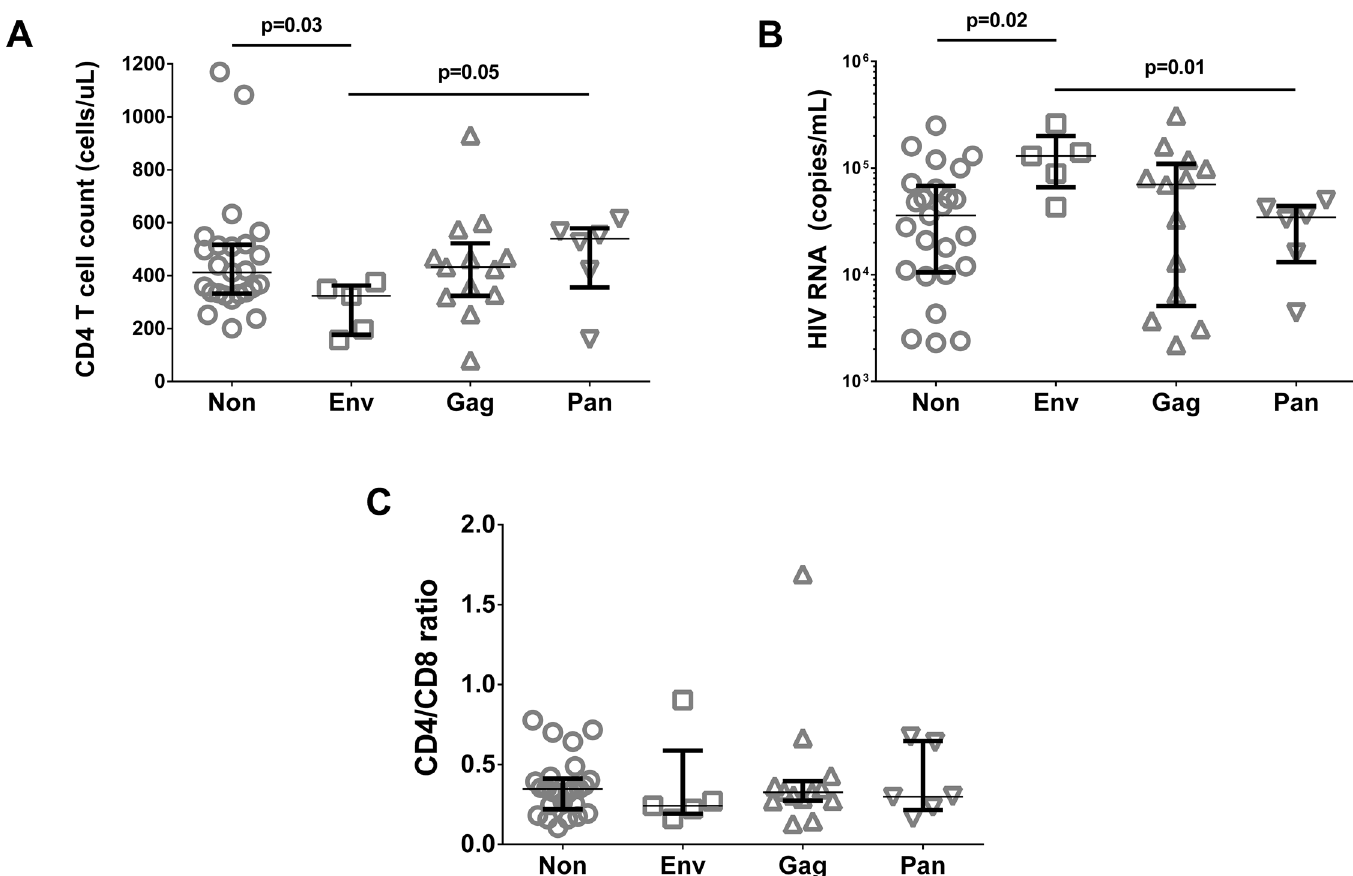
Fig 4. Lower CD4 counts and higher HIV viral loads in Env-regulators. (A) CD4 count, (B) Plasma HIV RNA and (C) CD4/CD8 ratio by regulator subgroup in the expanded cohort (n = 49). Median and upper/lower quartiles indicated. P-values derived from unpaired tests.